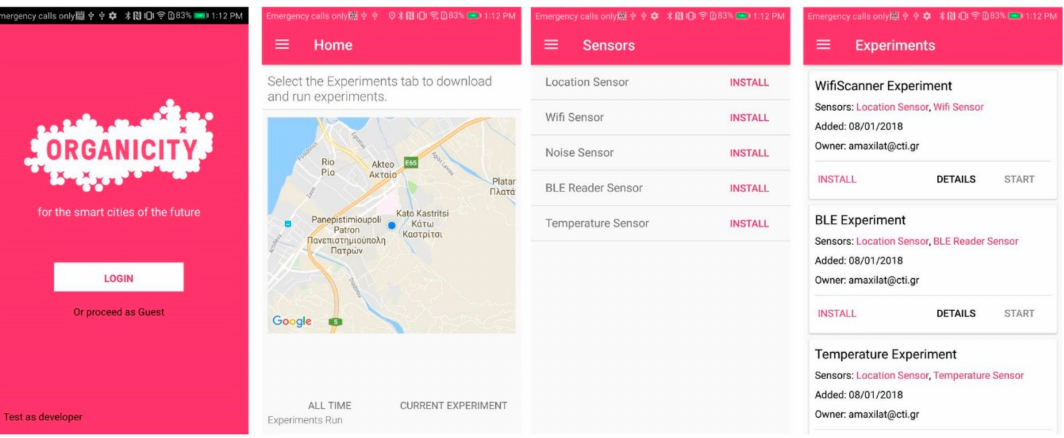
Figure 5. Screenshots from the Smartphone Experimentation Android